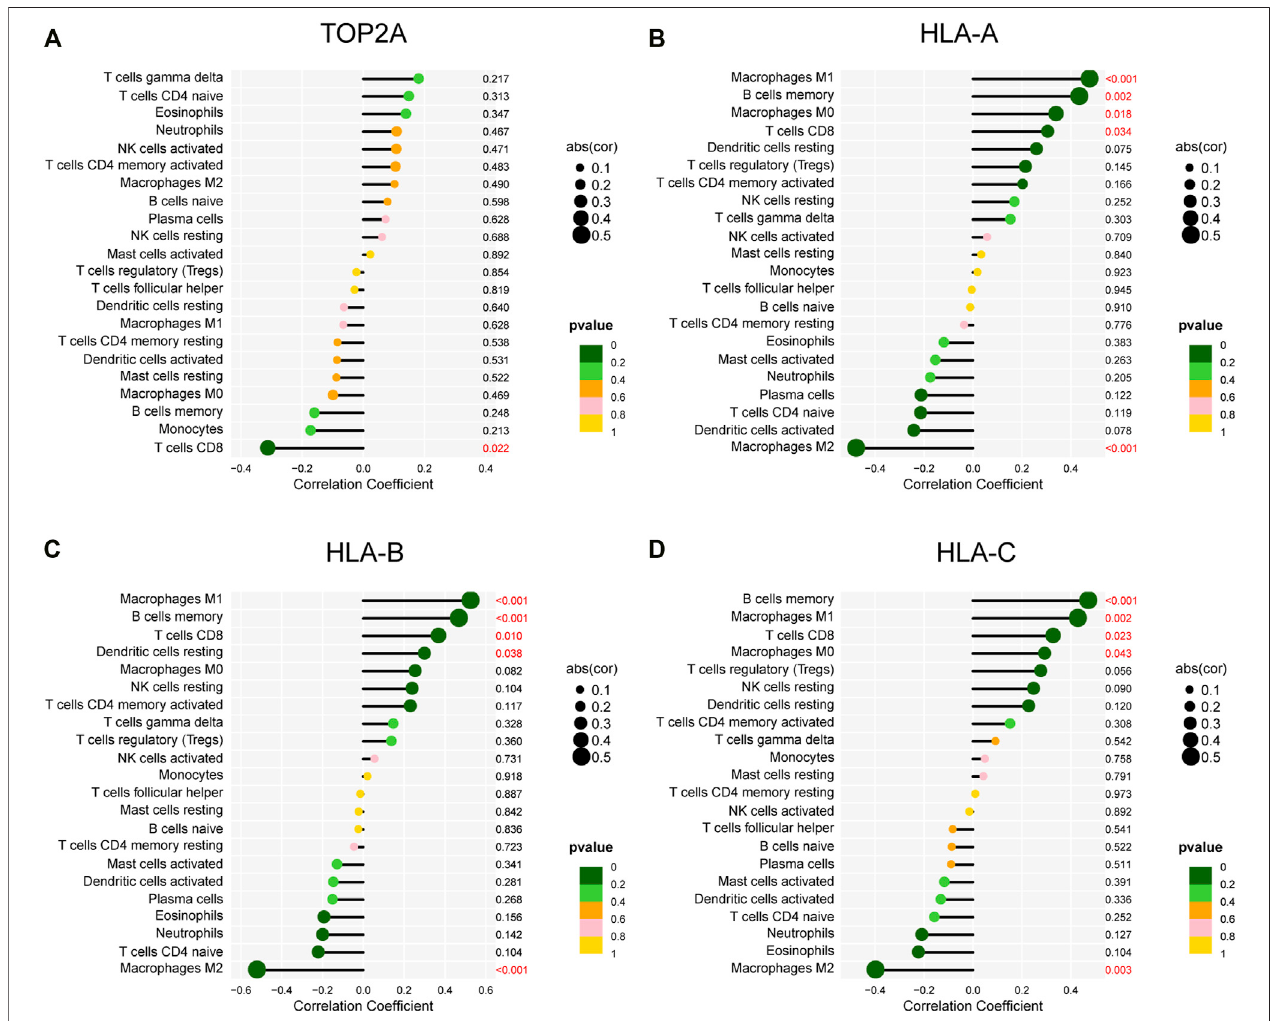
FIGURE 9 | Correlations of gene expression and in fi ltrating immune cells. (A – D) Correlations between TOP2A , HLA-A , HLA-B , and HLA-C expression and in fi ltrating immune cells.